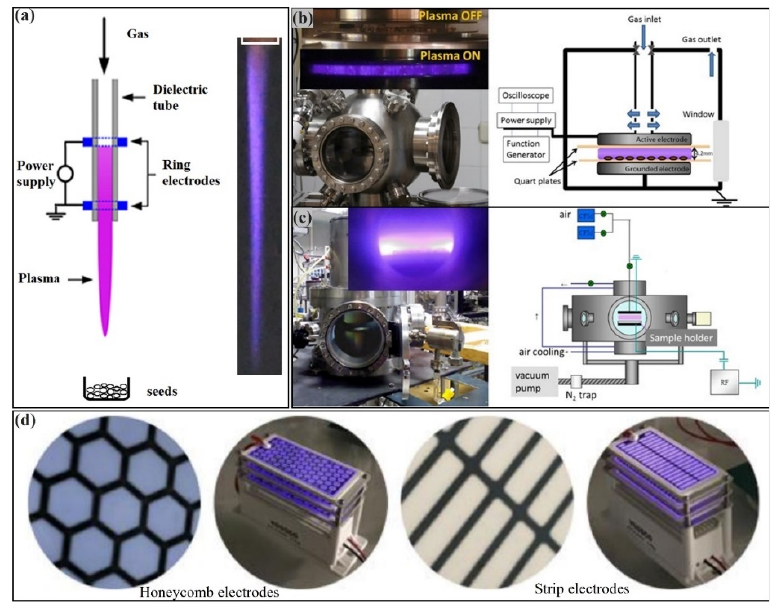
Figure 1. Some CAP sources used in plasma agriculture. ( a ) A CAP jet and its discharge photo [9]. ( b ) A DBD reactor and structure [10]. ( c ) A radiofrequency (RF) reactor and structure [10]. ( d ) Two surface DBD sources with honeycomb electrodes and strip electrodes [12].